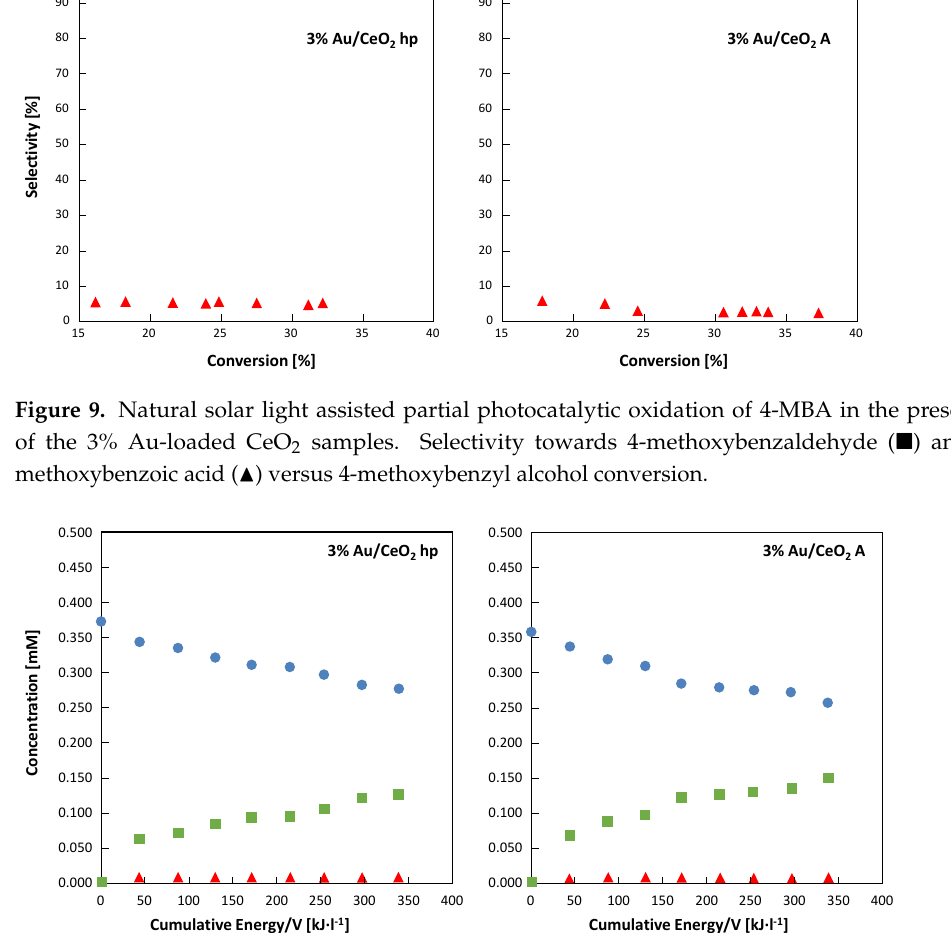
Figure 10. Natural solar light assisted partial photocatalytic oxidation of 4-MBA in the presence of the 3% Au-loaded CeO 2 samples. Evolution of 4-MBA concentration ( ● ), 4-MBAL ( ■ ) and 4-MBAcid ( ▲ ) versus natural sunlight cumulative energy (in the wavelength range 315–560 nm) entering the reactor per unit of volume of suspension.